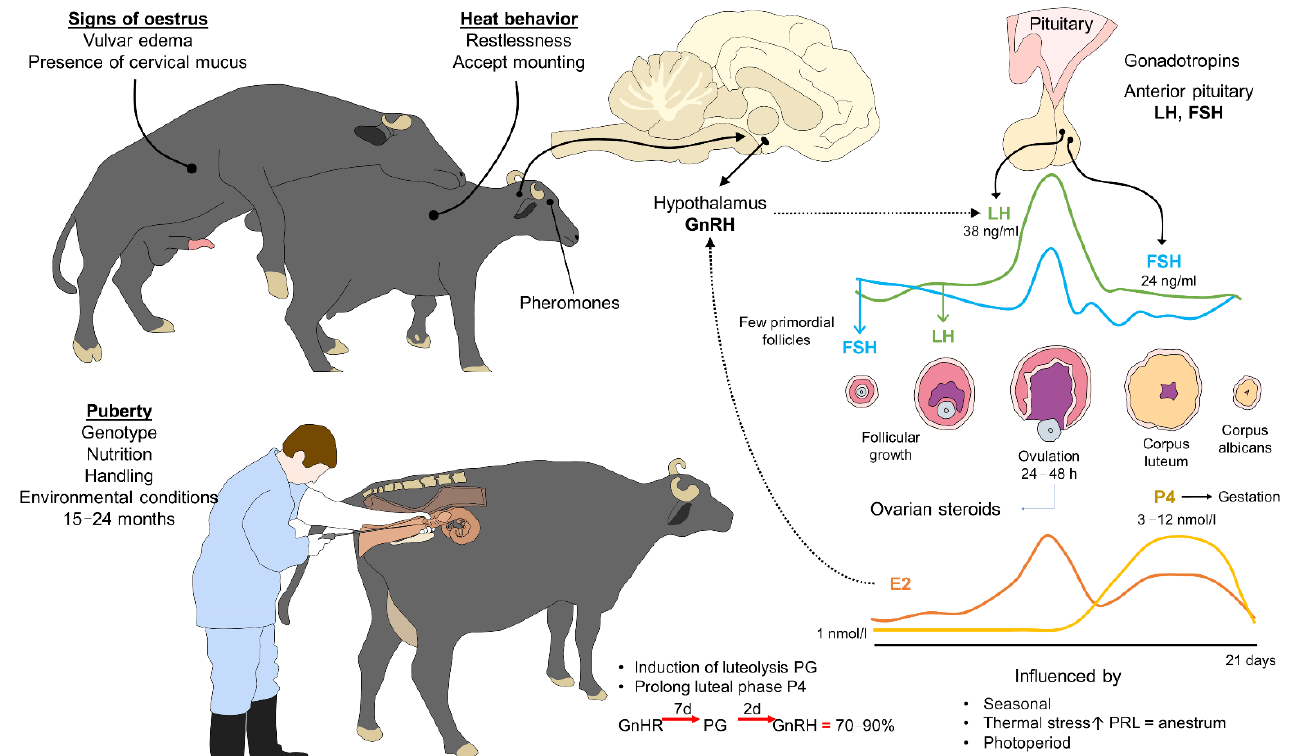
Figure 3. Neuroendocrinology of the estrus cycle, estrous detection, and artificial insemination technique. During estrus, multiple signs and behaviors may be present in female buffaloes. Concentrations of LH and FSH, two gonadotropins secreted by the anterior pituitary through the action of the hypothalamus, are the main hormones involved. When LH and FSH levels are sufficiently high, ovulation takes place (lasting 24 – 48 h in buffaloes) with the consequent secretion of E2. Estrogen levels decrease gradually while progesterone levels increase to restart the estrous cycle. Heat detection based on signs, behaviors, or hormone levels is an essential aspect of artificial insemination programs, where one main goal is to avoid influences by season or other factors. E2: 17β -estradiol;